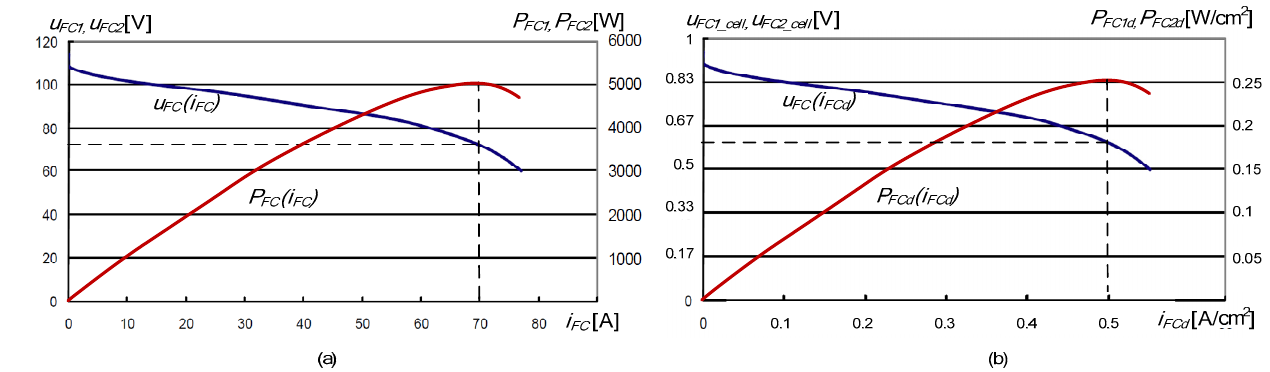
Figure 2. Voltage-current and power-current output characteristics of a single 5 kW stack of the fuel cell according to the fuel cell Figure 2. Output characteristics of a single 5kW stack of the fuel cell according to the fuel cell user manual [11]. ( a ) voltage